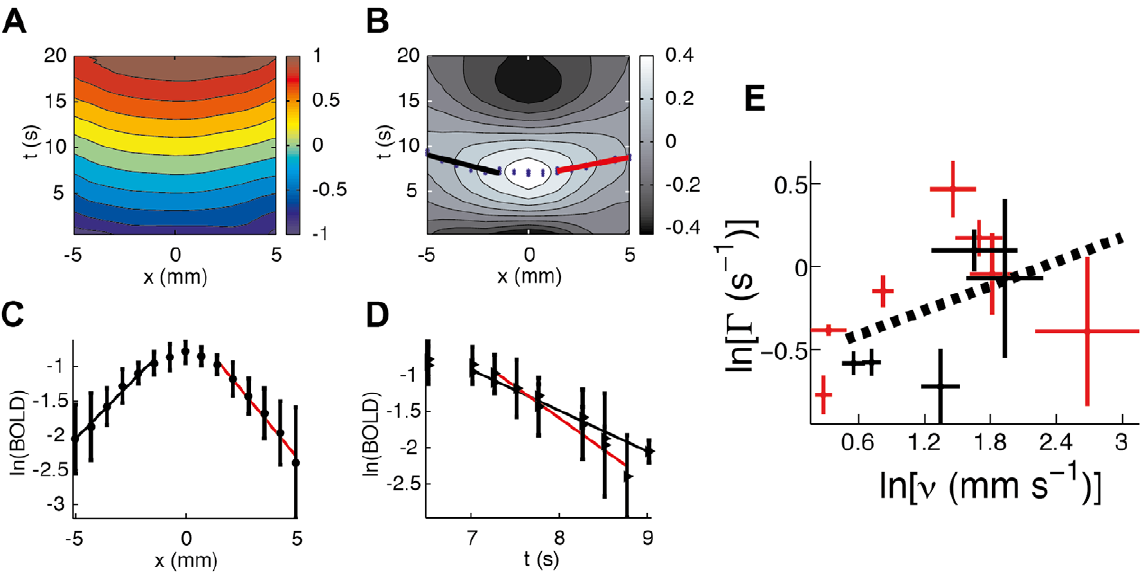
Figure 5. Quantifying the spatiotemporal response. A Calculation of the instantaneous phase reveal phase fronts of the response. These fronts are nearly stationary at the center and propagate with roughly constant velocity away from the center at | x | . 1 mm. They are well described with straight line fits, as seen in panel B: toward the fovea (F) (red) and toward the periphery (P) (black). Along these slopes the BOLD signal decays exponentially in time C: with decay constants C P = 2 0.56 6 0.04 s 2 1 , C F = 2 0.86 6 0.08 s 2 1 , and D: as a function of perpendicular distance, with decay constants K P =0.32 6 0.02 mm 2 1 , K F =0.38 6 0.02 mm 2 1 . The error bars are 1 s.e.m, and errors of the parameter estimates are 1 s.d. E: Propagation velocity and damping rate for each of the subjects and their hemispheres. Red data points are the foveal values (F), while values toward the periphery (P) are shown in black. These points show a wide scatter, corresponding to individual differences, but there is a significant positive correlation. A straight line fit to this log-log plot yields an overall trendline that corresponds to a power law with exponent 0.24 6 0.09 (s.d).